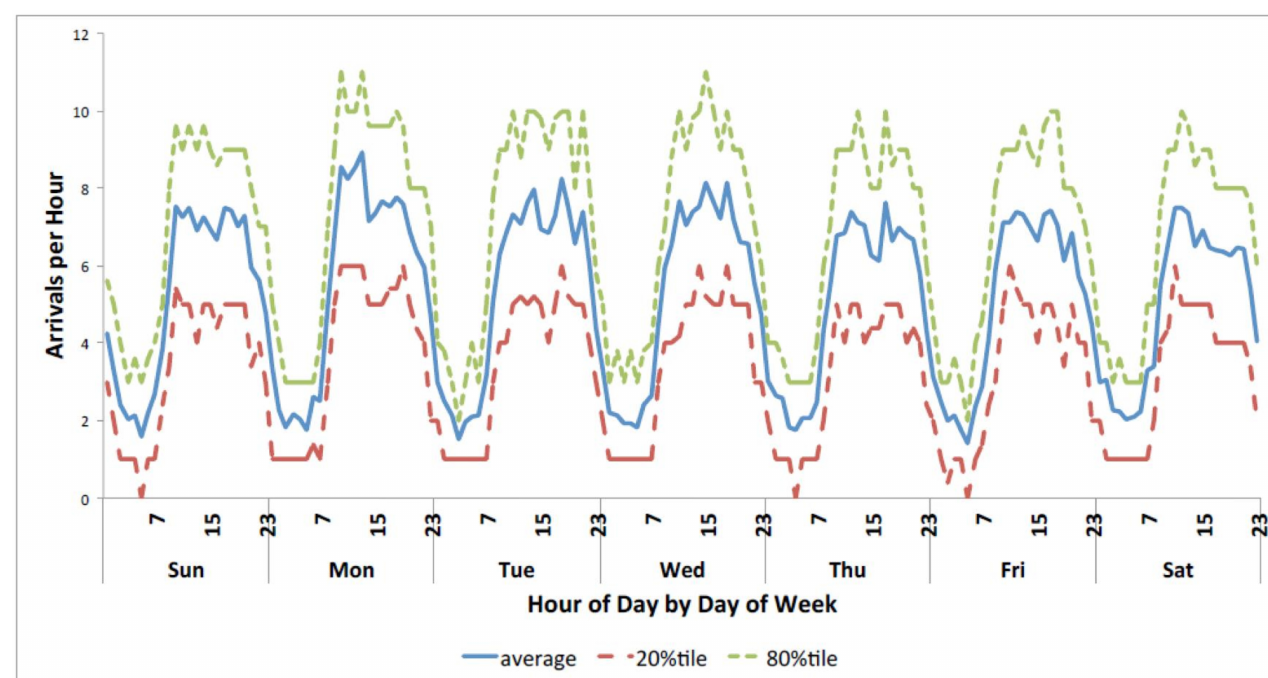
Figure 3. ED hourly arrival